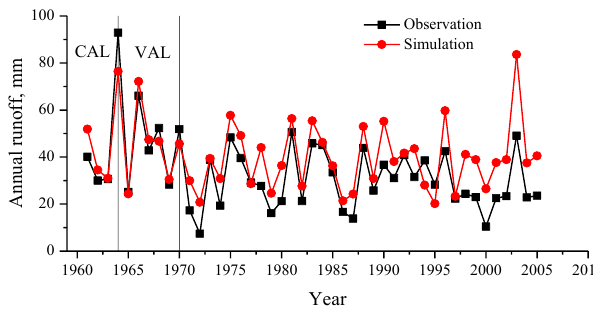
Figure 3. Observed and simulated runoff at the Zhangjiashan sta- tion on the Jing River during 1961–2005 (CAL and VAL indicate the periods used for model calibration and validation,